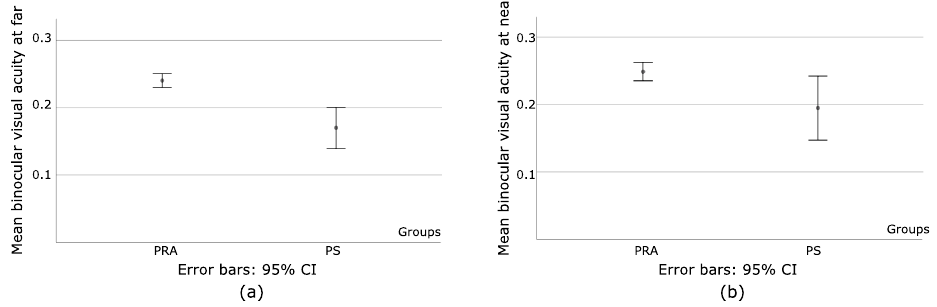
Figure 4. ( a ) Represents the mean value of binocular visual acuity at far and s.d in PRA and PS; ( b ) the mean value of binocular visual acuity at near and s.d in PRA and PS. Despite higher values being obtained in PS, the heterogeneity shown by the s.d reflects a deeper imbalance for the sensory and motor systems at both